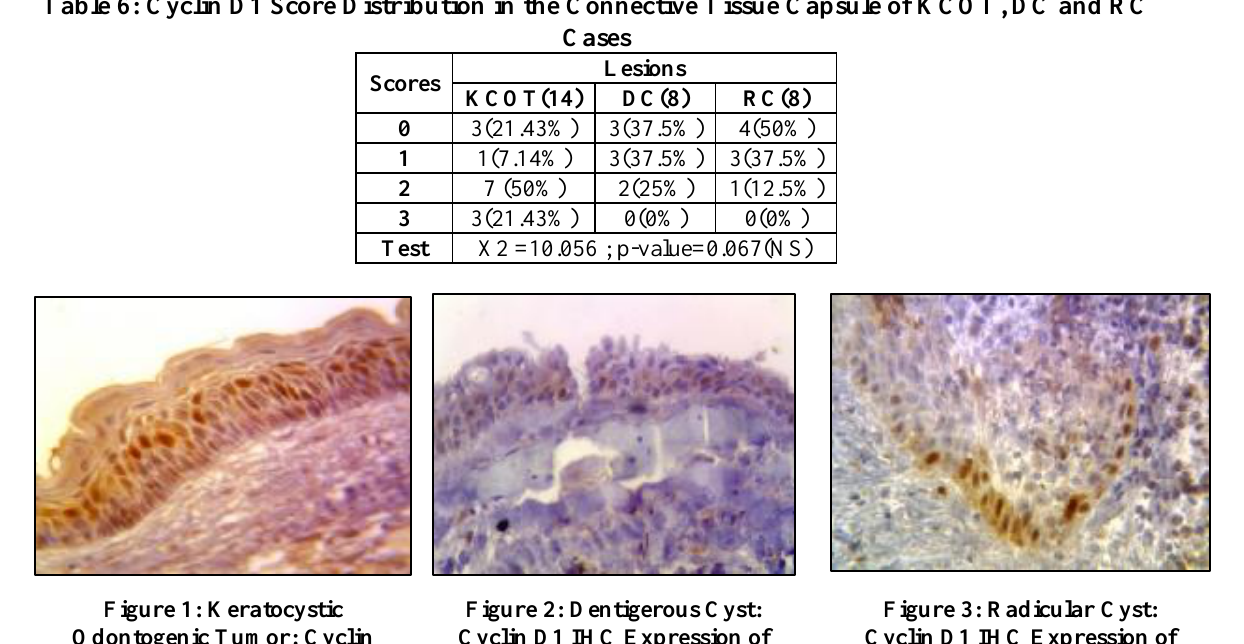
Figure 1: Keratocystic Figure 2: Dentigerous Cyst: Odontogenic Tumor: Cyclin Cyclin D1 IHC Expression of D1 IHC Expression of Cystic Cystic Epithelium with Epithelium with Strong Moderate Intensity and Intensity and Focally Pattern Focally Pattern with with Immunoreactivity in Immunoreactivity in Basal Basal and Parabasal Layer and Parabasal Layer X400. X400.